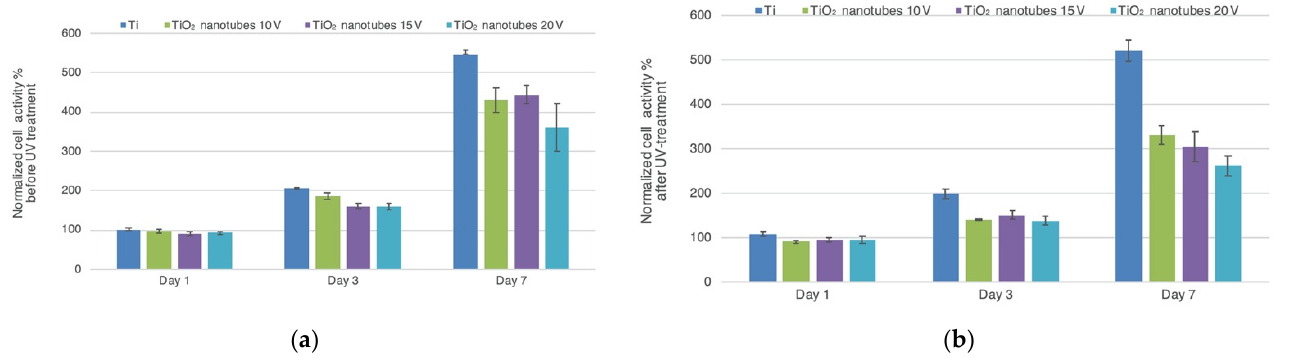
Figure 4. Proliferation of human gingival fibroblasts on the investigated specimens ( a ) before and ( b ) after UV ‐ treatment. The reduction of AlamarBlue TM reagent with commercial pure titanium before UV ‐ treatment substrate at the 1 d time ‐ point was set to 100%. Data are presented as mean ± standard deviation ( n = 6).